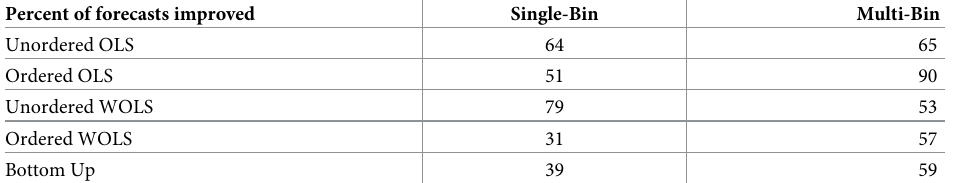
Table 2. Percent of forecasts improved over original forecast distribution for the four coherence methods described, in addition to the baseline bottom up model under both single-bin and multi-bin skill. We omit the independent forecasts since they are the reference model for percentage of forecasts improved. Notice that WOLS unordered showed the greatest improvement under single-bin scoring but showed the least improvement under multi- bin scoring. This demonstrates that the scoring rule used influences the performance of the coherence